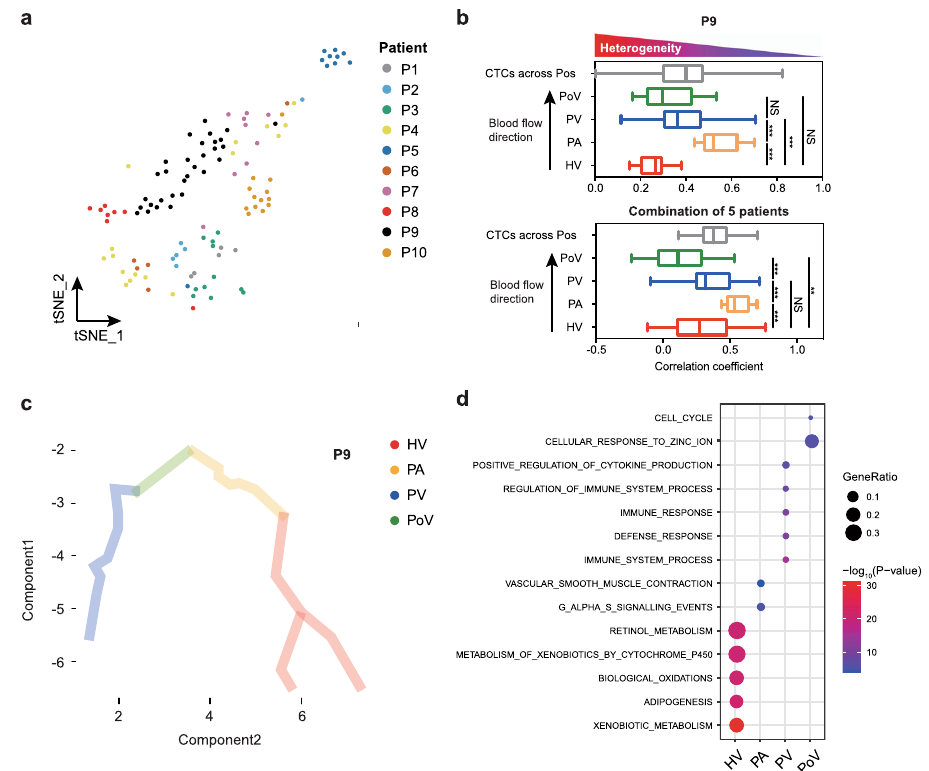
Fig. 2 Spatial transcriptional heterogeneity in CTCs. a t -SNE plot of CTCs from ten patients reveals their interpatient heterogeneity. b Pearson correlation analysis showing cell-to-cell variability for CTCs drawn from four vascular sites in patient P9 (upper panel) and fi ve patients combined (lower panel). The two- sided Wilcox test was used. Data are presented using box and whisker plot (median, lower quartile, upper quartile, minimum, and maximum values). n = 45 cells in HV; n = 12 cells in PA; n = 40 cells in PV; n = 16 cells in PoV. ** P <0.01, *** P <0.001. Exact P values in upper panel: HV vs PA, P = 1.18×10 − 9 ; PA vs PV, P = 2.79×10 − 4 ; HV vs PV, P = 2.36×10 − 4 . Exact P values in lower panel: HV vs PA, P = 2.32×10 − 3 ; PA vs PV, P = 7.00×10 − 4 ; PV vs PoV, P = 1.50×10 − 5 ; HV vs PoV, P = 6.13×10 − 3 . Bar = median, box plot = quartiles. c Pseudotemporal kinetics of CTCs in patients P9. d Bubble chart presenting the